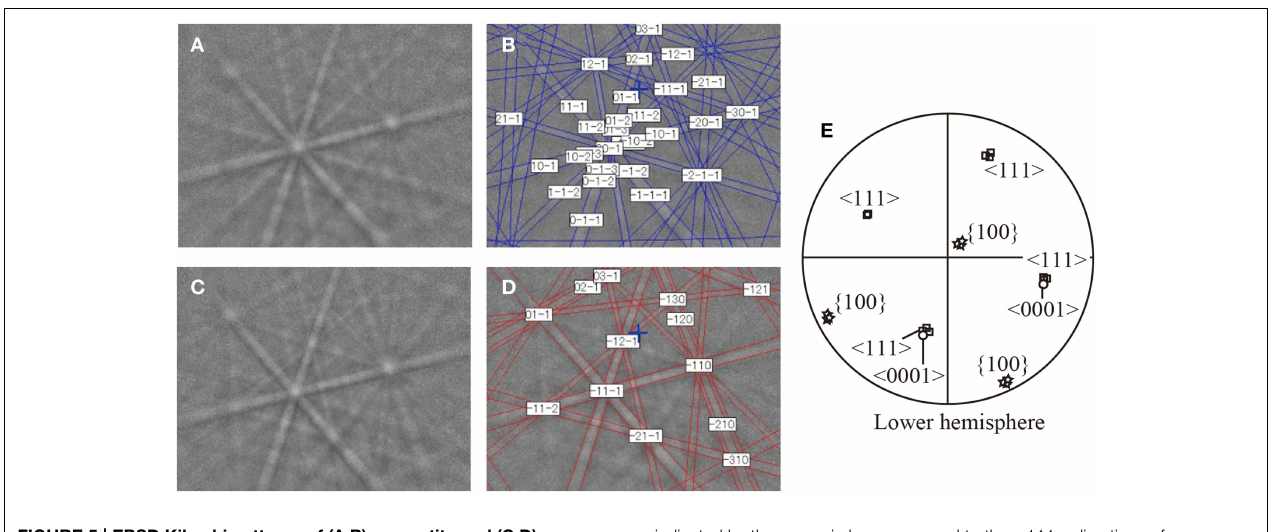
FIGURE 5 | EBSD Kikuchi patterns of (A,B) magnetite and (C,D) hematite. (E) Superposition of the crystal orientations of magnetite and hematite in the lower hemisphere. The < 0001 > directions of hematite